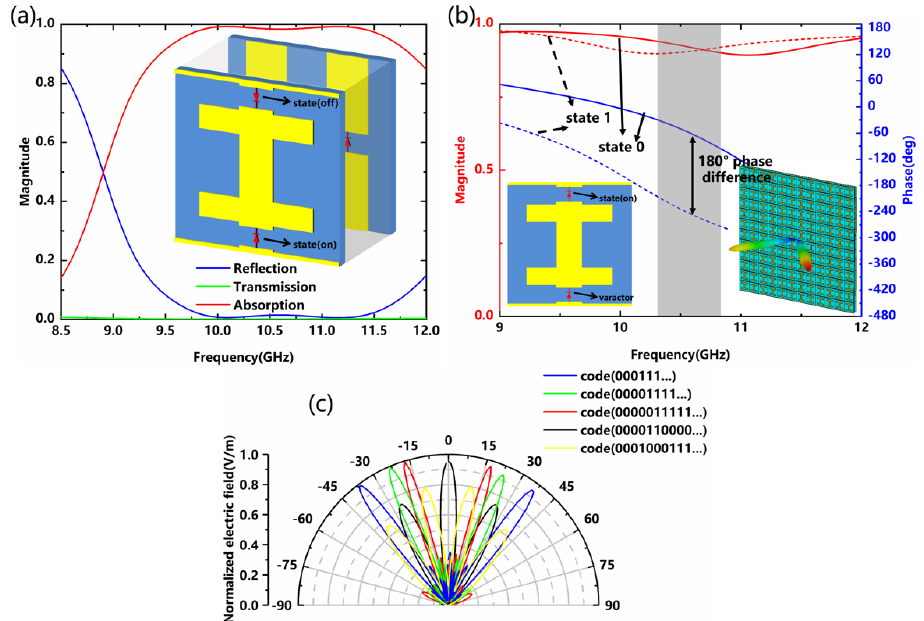
Figure 6. ( a ) Absorption effect under two PIN diode-1 in opposite states; ( b ) Simulated reflection phase and amplitude curves of the designed metadevice in state 0 and state 1 of the varactor; ( c ) Normalized electric field of the metadevice with different coding sequences.